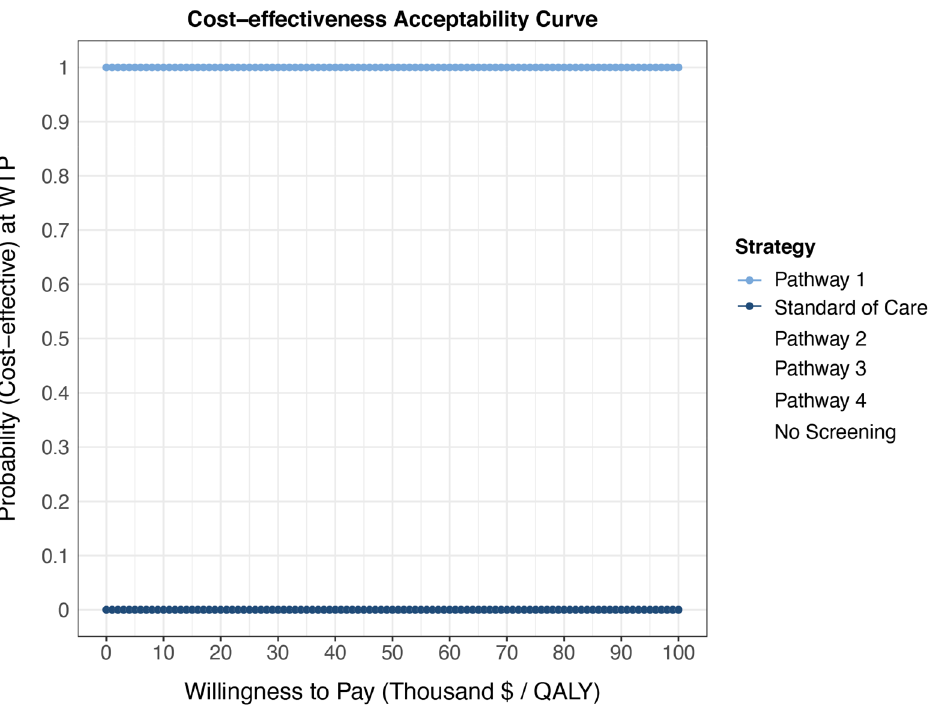
Figure 4. Cost-effectiveness Acceptability Curve of all pathways and no screening